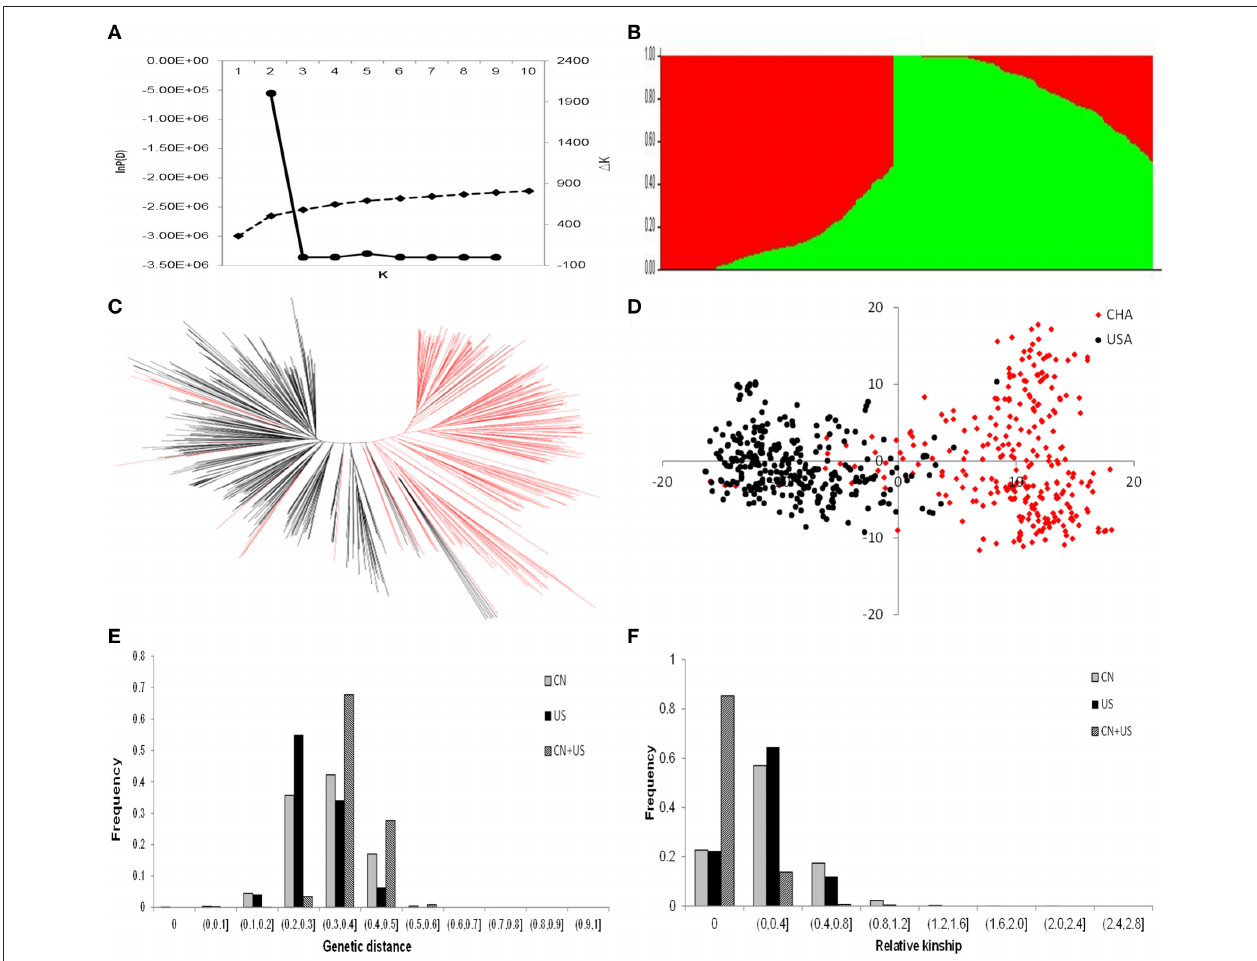
FIGURE 4 | Genetic structure and relatedness of populations from China and America. (A) Evolution of the natural logarithm probability of the data against K and the magnitude of 1 K for each K- value; (B) Clustering for K = 2 for the entire set of soybean accessions. Each individual is represented by a vertical bar, partitioned into colored segments with the length of each segment representing the proportion of the individual’s genome from groups when k = 2; (C) Neighbor-joining tree constructed using SNP data; (D) Principal component analysis for the entire set of soybean accessions. Soybean accessions from China are shown in red, and soybean accessions from the United States of America are shown in black; (E) Distribution of the genetic distance for 277 Chinese and 300 American soybean accessions; and (F) Distribution of the kinship values for 277 Chinese and 300 American soybean accessions. CN is for China; and US is for United States of